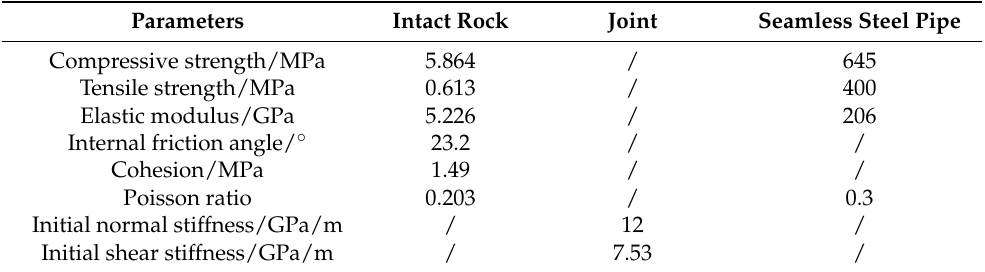
Table 2. Physical and mechanical parameters of the intact rock, joint, and seamless steel pipe.